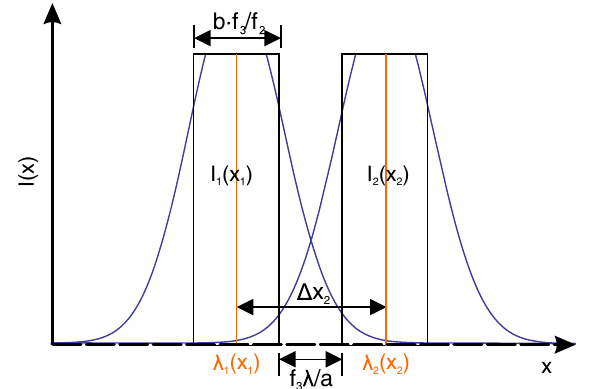
FIG. 4. Illustration of the resolution limit of two closely overlapping spectral lines, where x denotes a position on the spectrometer detector and corresponds to some wavelength λ ð x Þ